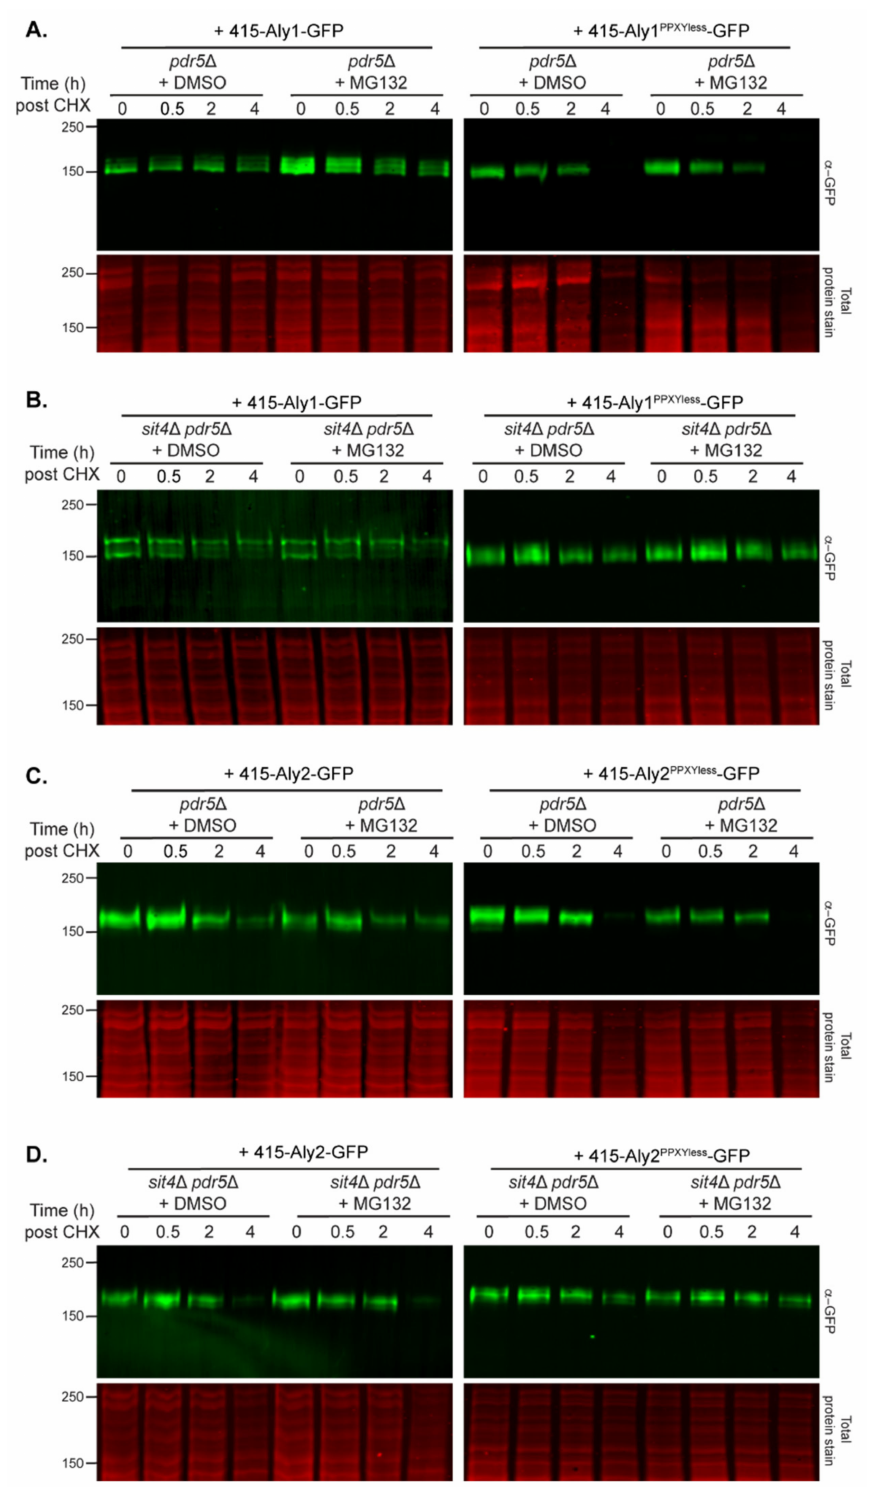
Figure 8. Inhibition of the proteasome does not lead to stabilization of Alys: ( A – D ) Whole-cell extracts from cells expressing ( A ) Aly1-GFP, ( B ) Aly1 PPXYless -GFP, ( C ) Aly2-GFP, or ( D ) Aly2 PPXYless -GFP were treated with either vehicle control (DMSO) or MG132 for 60 min and then cycloheximide (CHX) for the time indicated (hours); proteins were resolved by SDS-PAGE. Anti-GFP antibody was used to detect tagged α -arrestins and REVERT total protein stain was used as a loading control. Blots shown are one representative from 2–3 replicate experiments. Molecular weights are shown on the left side in